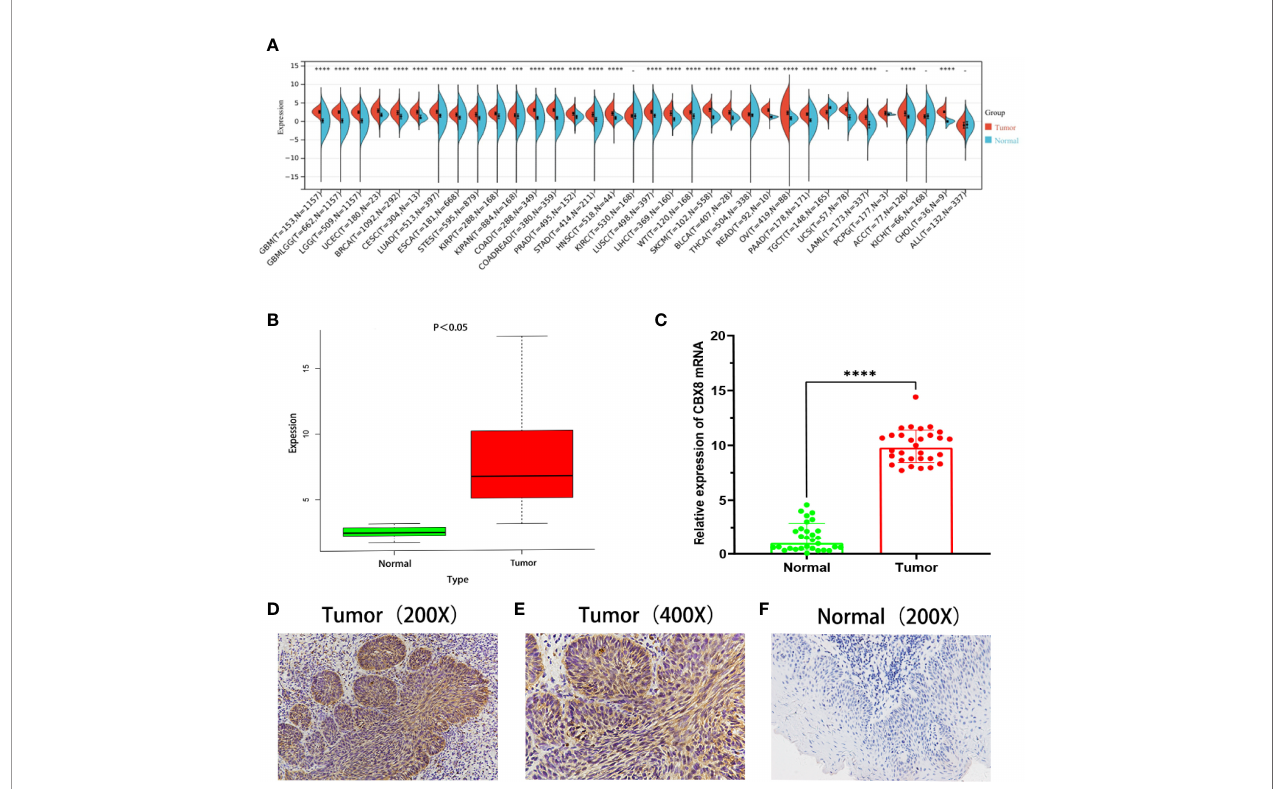
FIGURE 1 | CBX8 was highly expressed in LSCC tissues. (A) Expression of CBX8 mRNA in different cancer types according to TCGA and GTEx data. (B) Expression of CBX8 in laryngeal squamous cell carcinoma in TCGA database. (C) Real-time quantitative PCR was used to detect the relative expression of CBX8 mRNA in laryngeal squamous cell carcinoma and paired normal tissues. (D – F) IHC detected the expression of CBX8 protein in laryngeal carcinoma and paired normal tissues. (*P < 0.05, ***P < 0.001, ****P <